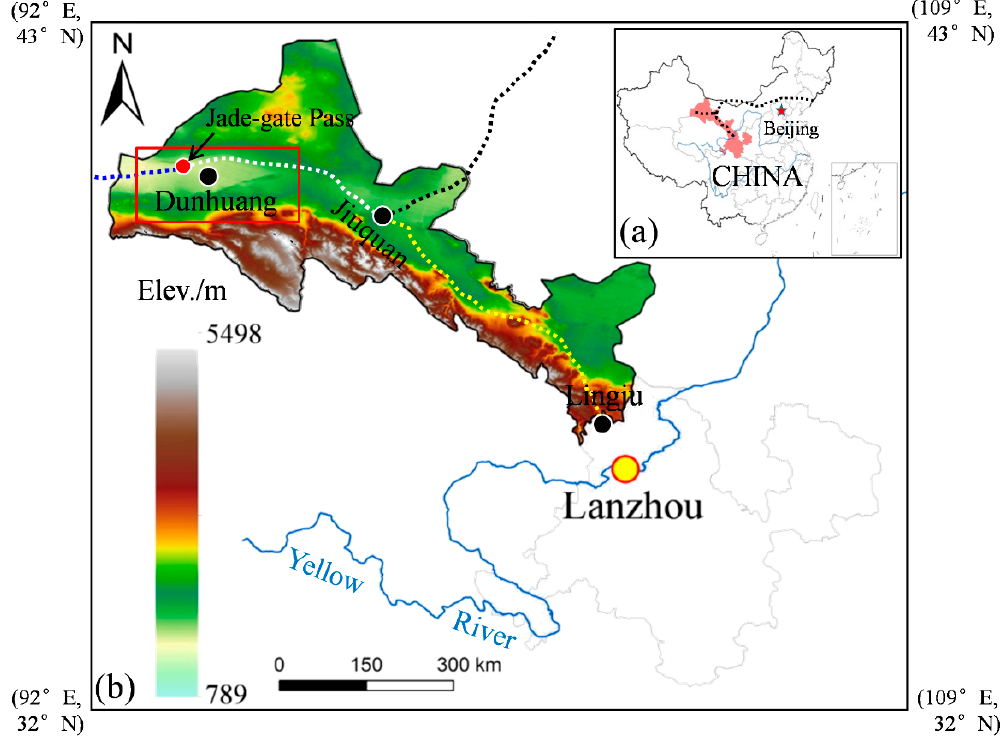
Figure 1. General locations of the Great Wall of Han Dynasty (GH) ( a ) and the topography of Hexi Corridor ( b ) in China; the dotted lines represent different sections of the GH in Hexi Corridor.